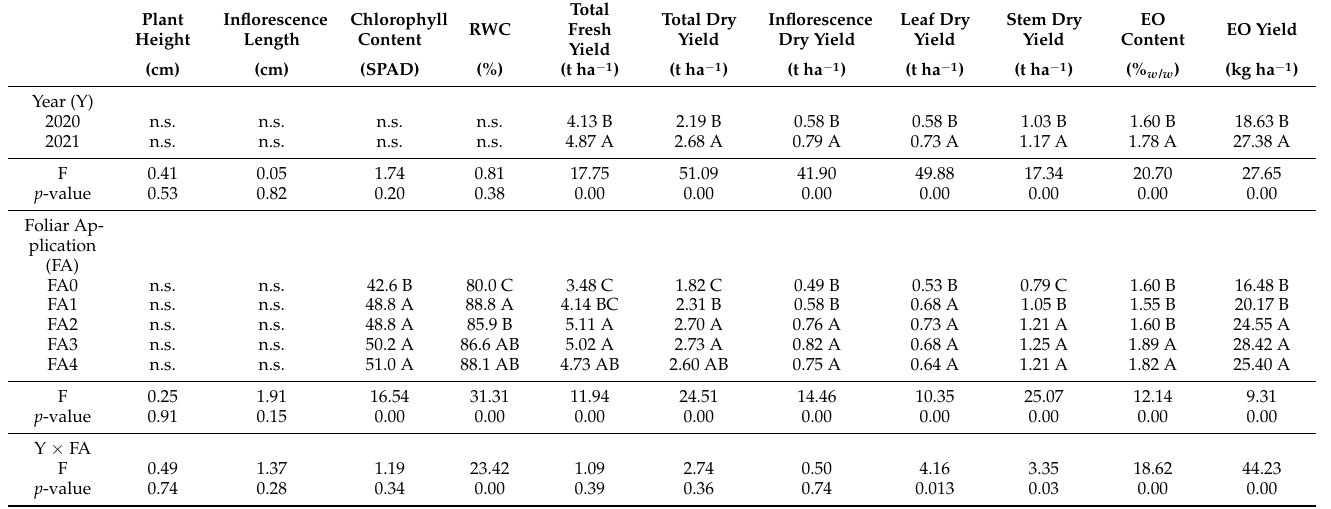
Table 1. Effects of year (Y), foliar application (FA) and their interaction (Y × FA) on morphological and yield parameters.